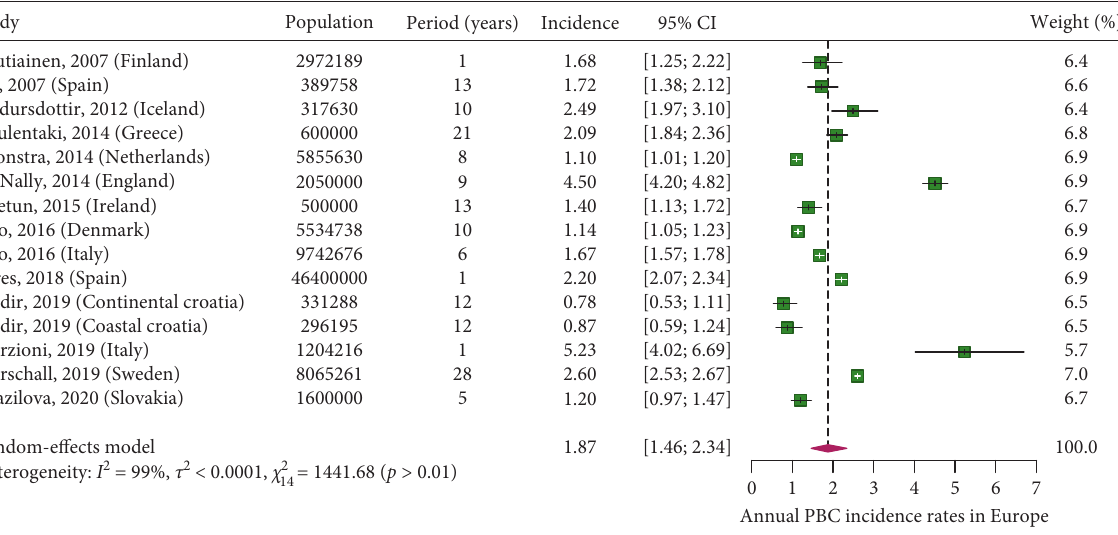
Figure 8: Annual PBC incidence rates in